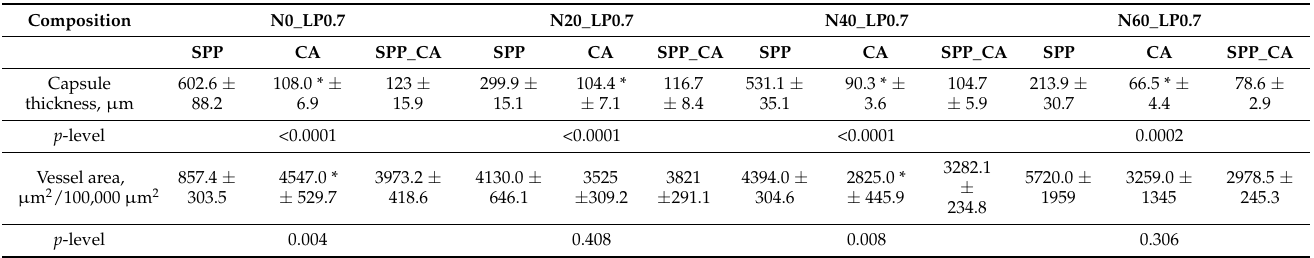
Table 9. The average thickness of fibrous capsules ( µ m) and the relative area of vessels per 100 thousand µ m 2 of capsule area. *—significant